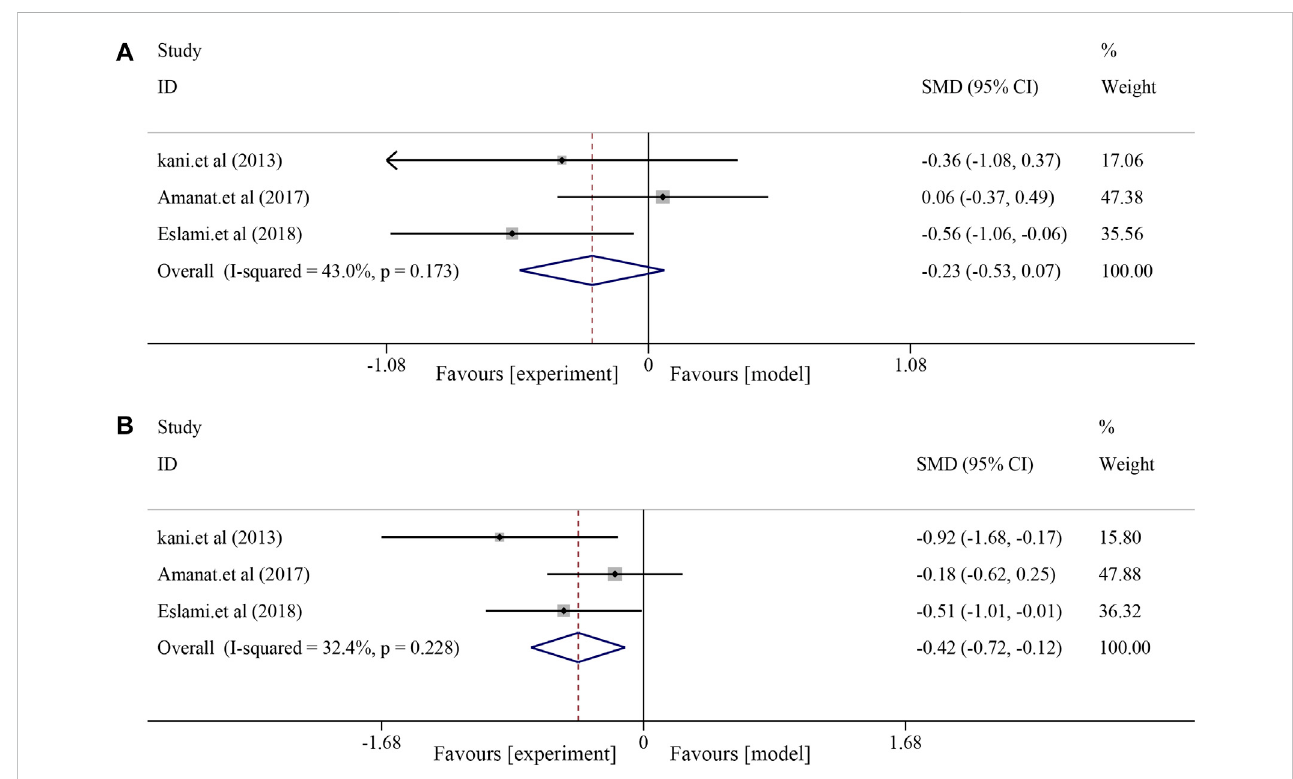
FIGURE 5 Effects of soybean on AST and ALT levels in clinical studies. (A) Pooled effect of AST. (B) Pooled effect of ALT.